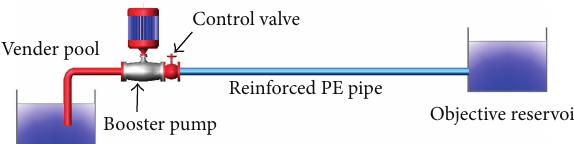
Figure 11: Basic model of a water supply PE pipe